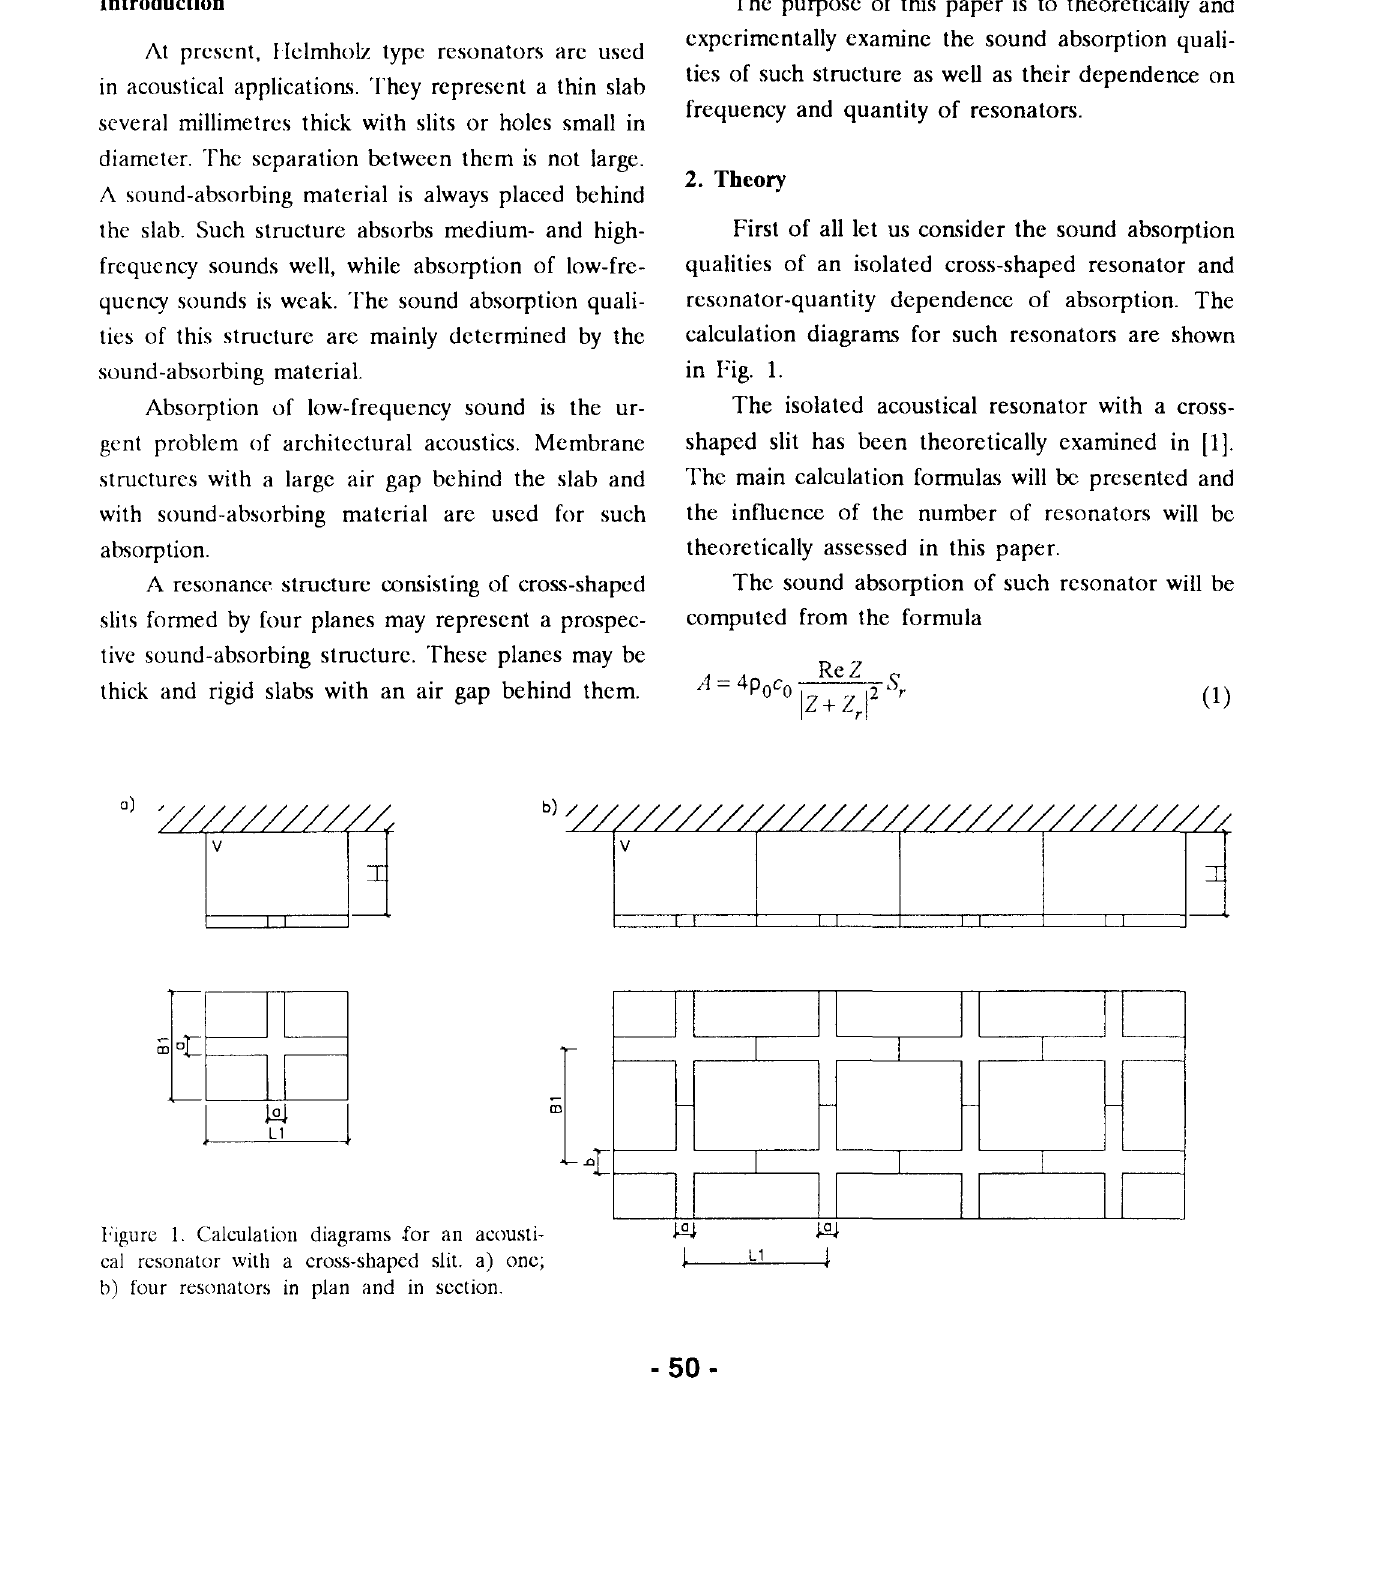
Figure I. Calculation diagrams .for an acousti cal resonator with a cross-shaped slit. a) one; b) four resonators in plan and in